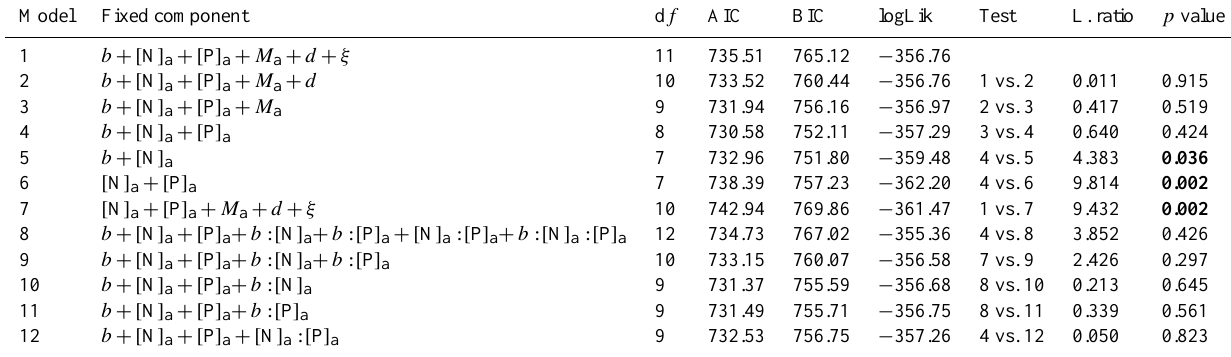
Table 4. Stepwise selection process for the fixed component of the linear mixed-effect model: photosynthetic capacity ( A max , a ) as response variable. Categorical variable b has two levels: forest and savanna for the contrasting vegetation types. Continuous explanatory variables are [ N ] a , [ P ] a , leaf mass per unit area ( M a ), leaf dry matter content ( ξ ) and leaf thickness ( d ). The effect of dropping sequential terms was tested by comparing the nested model variants. Model variants were all run using the maximum likelihood method; the model’s random component was identical in all variants. Test parameters and statistics are d f , degrees of freedom; AIC, Akaike information criteria; BIC, Bayesian information criteria; logLik, maximum likelihood; the likelihood ratio statistic and associated p value. Models with the same degrees of freedom are not nested one in the